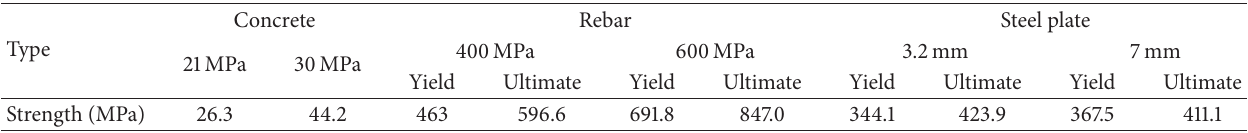
Table 4: Material properties of concrete, rebars, and steel